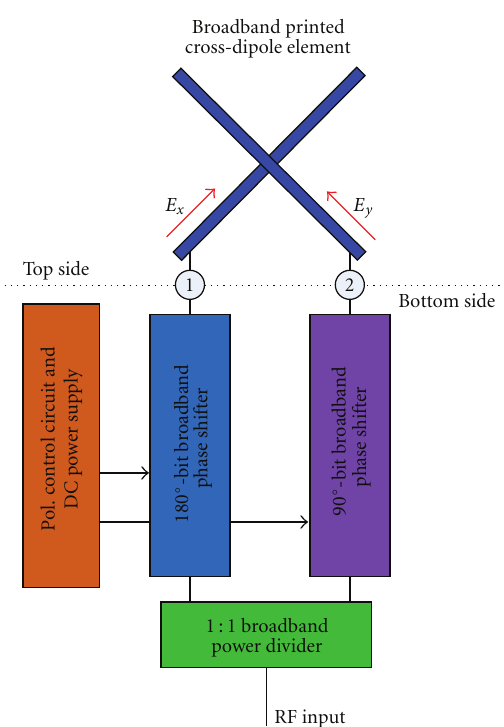
Figure 1: Internal block diagram of BPCDE PR.